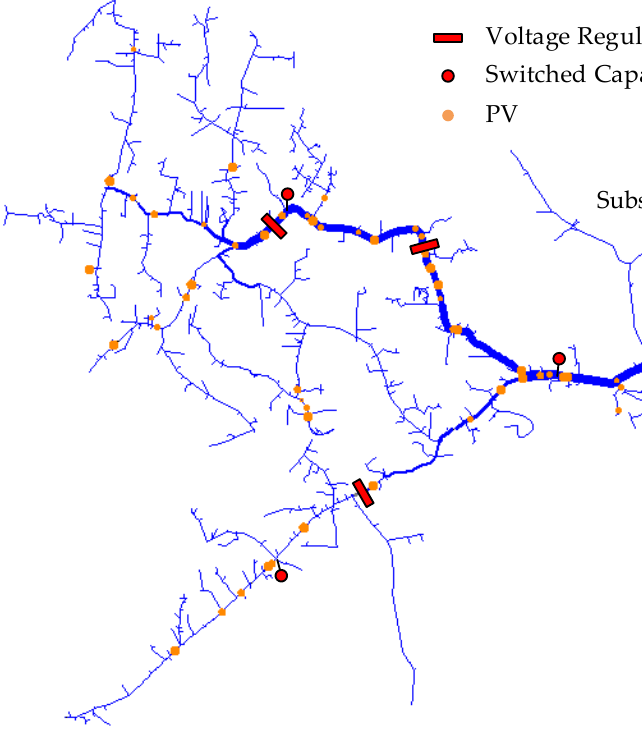
Figure 5. Sample system.